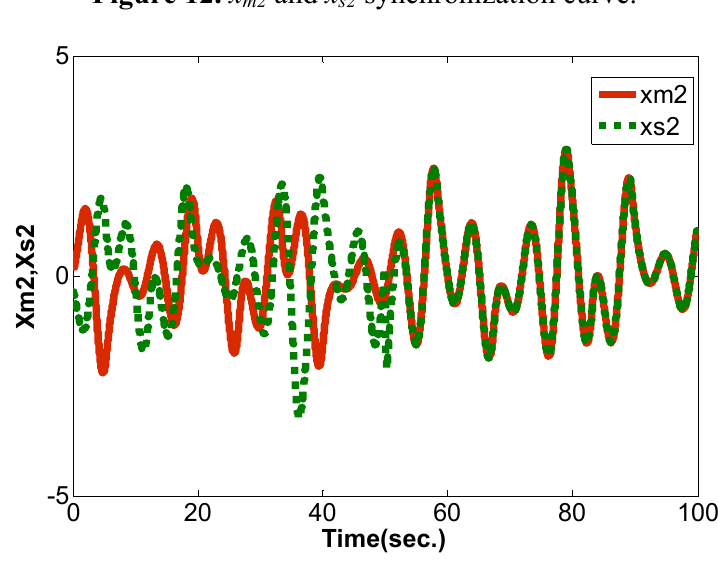
and x synchronization curve. m2 s2